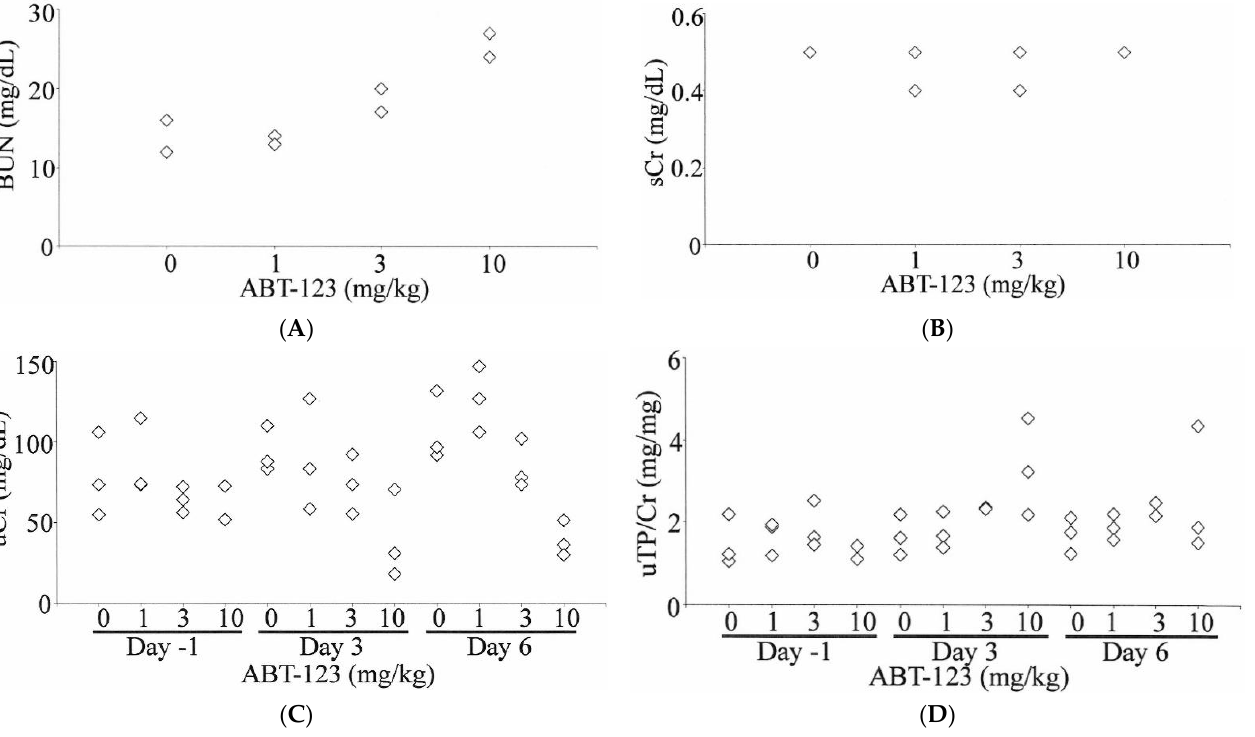
Figure 2. Effects of ABT-123 on conventional kidney injury biomarkers in rats. Male SD rats were administered with ABT-123 at 0, 1, 3, and 10 mg/kg/day once daily for seven days. BUN ( A ) and serum creatinine ( B ) were evaluated on Day 8 at necropsy (24 h after the last dose). Urinary creatine ( C ) and total protein ( D ) were measured at baseline, Day three, and Day six. Each diamond represents an individual animal.